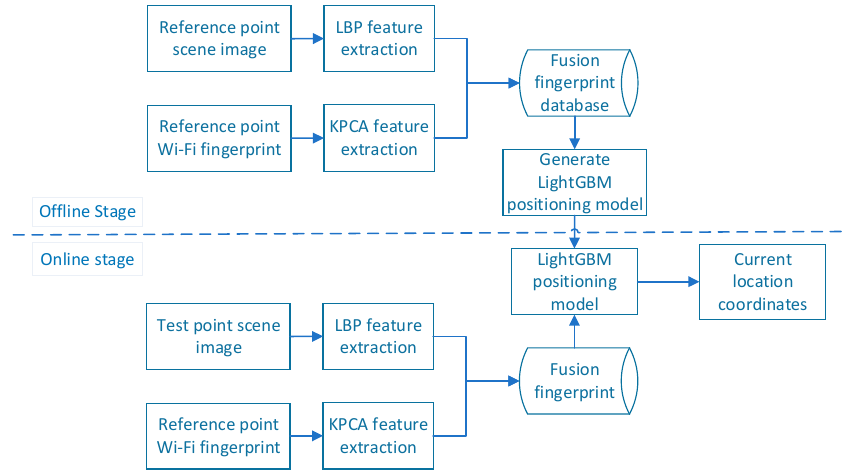
Figure 1. Flow chart of merged location fingerprint positioning